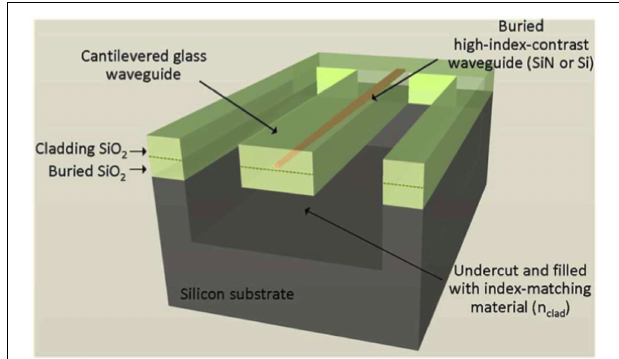
FIGURE 8 | Spot-size converter for silicon wire waveguides. The silicon is inverse tapered inside a suspended glass waveguide. The silicon substrate has been etched away under the suspended glass waveguide.